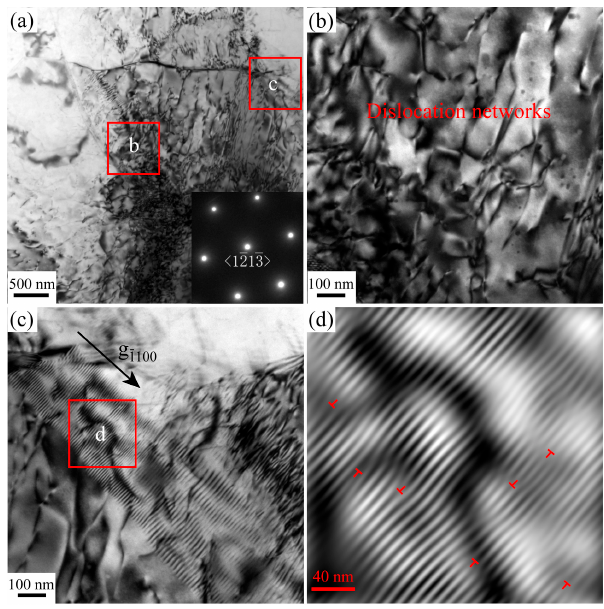
Figure 7. TEM observation of AZ31B processed by pure torsion along a < 1213 > direction: ( a ) schematic of three observation positions; ( b ) center of bar; ( c ) middle zone; ( d ) outer zone.